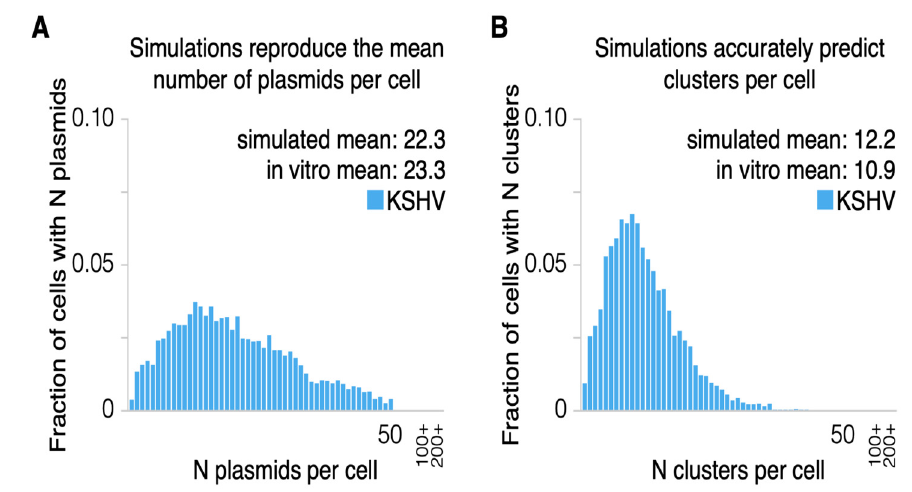
Figure 6. Simulations based on the numbers of KSHV plasmids per cell measured by PCR accurately predict the distribution of clusters per cell measured by FISH [16]. ( A ) Simulations reproduce the mean number of plasmids per cell (blue dot: simulated mean, gray dot: measurements in vitro). As described above, adjusting only the selective advantage coefficient is sufficient to match the mean copy number of plasmids per cell. Here, the coefficient was set optimally to 0.07, which reproduced the mean number of plasmids per cell identified in vitro by qPCR after 20 generations of burn-in. The simulation was run for 30 generations to confirm that the distribution was in equilibrium. ( B ) The mean number of simulated clusters per cell closely matched the counts of plasmids clusters in vitro via FISH [2].